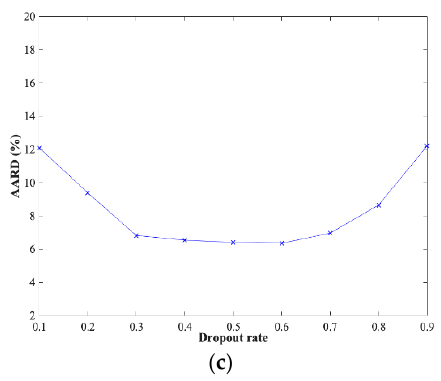
Figure 7. Effect of dropout rate on prediction performance: ( a ) error curve of water saturation; ( b ) error curve of pressure; ( c ) error curve of oil rate.